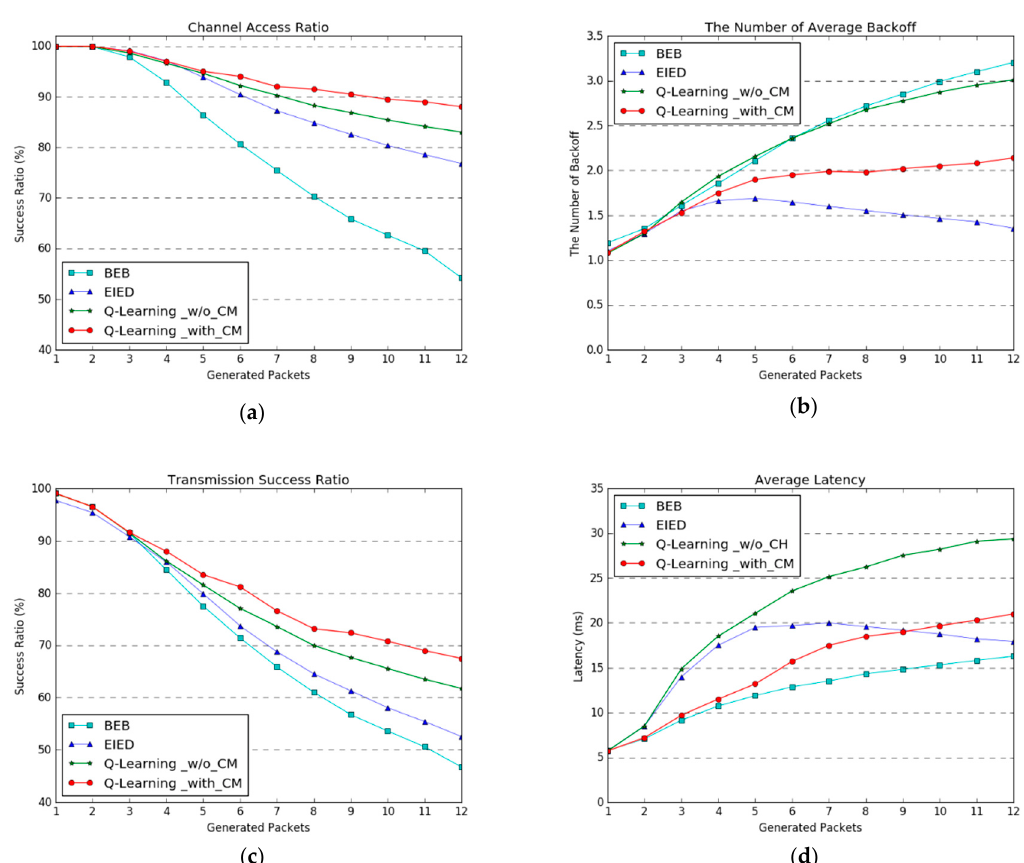
Figure 4. Experimental results for our proposed Q-learning-based adaptive channel access with channel monitoring method in comparison with other backoff methods: ( a ) Performance of channel access ratio, ( b ) number of average backoff for accessing the clear channel, ( c ) transmission success ratio, and ( d ) average latency when a packet is successfully transmitted. The horizontal axes of the graphs indicate the packets-per-second generated by a node at send interval, which represents the channel congestion level.